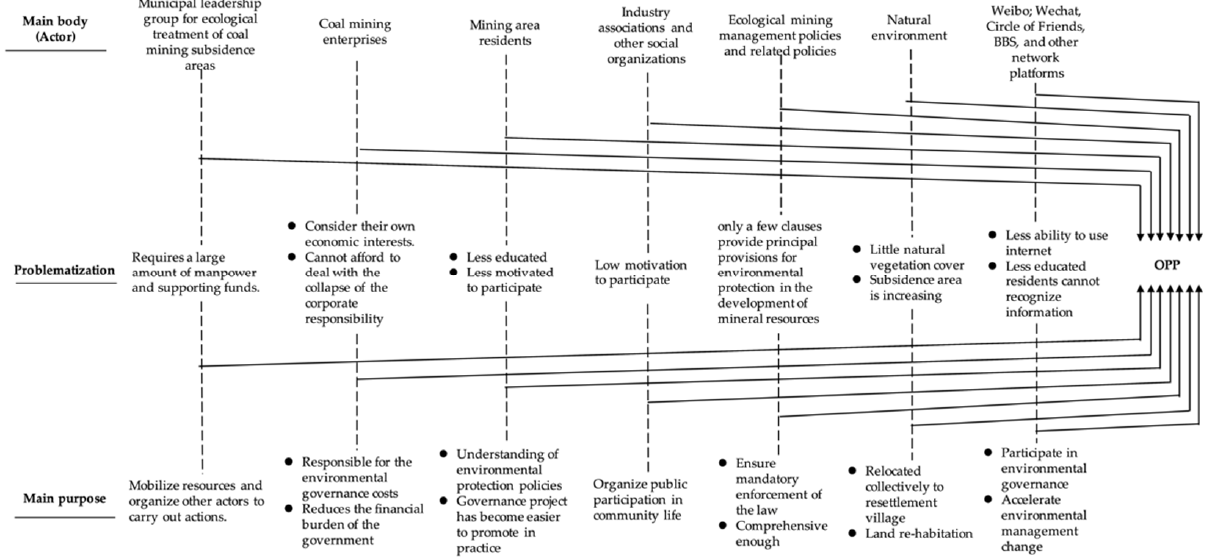
Figure 5. Problems, purposes and OPP of various actors: Participation in governance. Source: Orga- nized by the authors.